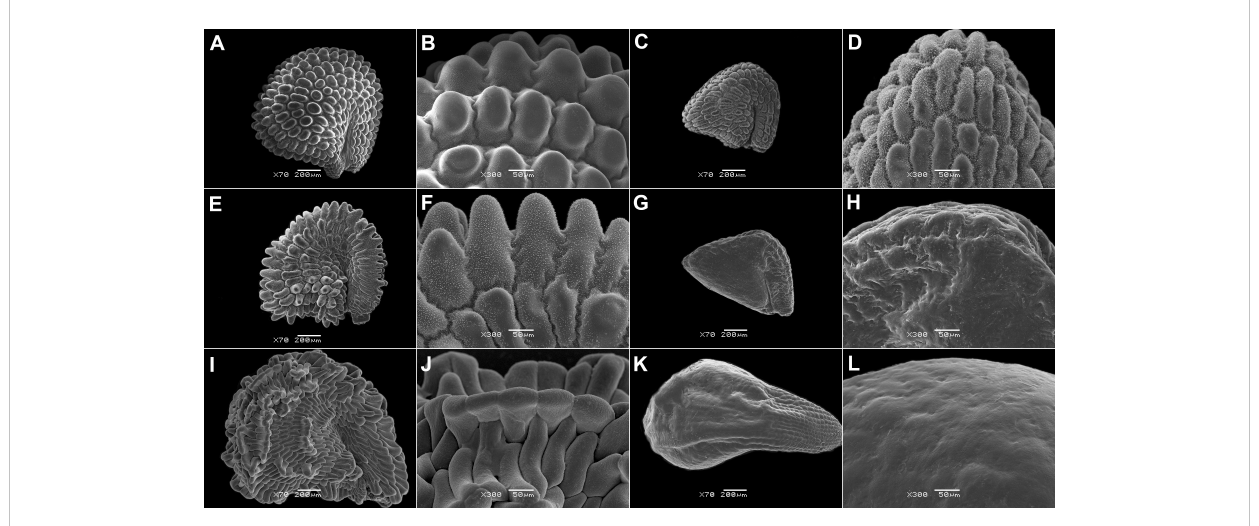
FIGURE 5 SEM micrographs of seeds of selected Mesembryanthemoideae species. (A, B) Mesembryanthemum cordifolium , (C, D) M. aitonis , (E, F) M. lignescens , (G, H) M. nodi fl orum , (I, J) M. rabiei , and (K, L) M. nucifer . Magni fi cation: (A, C, E, G, I, K) 70×; (B, D, F, H, J, L)